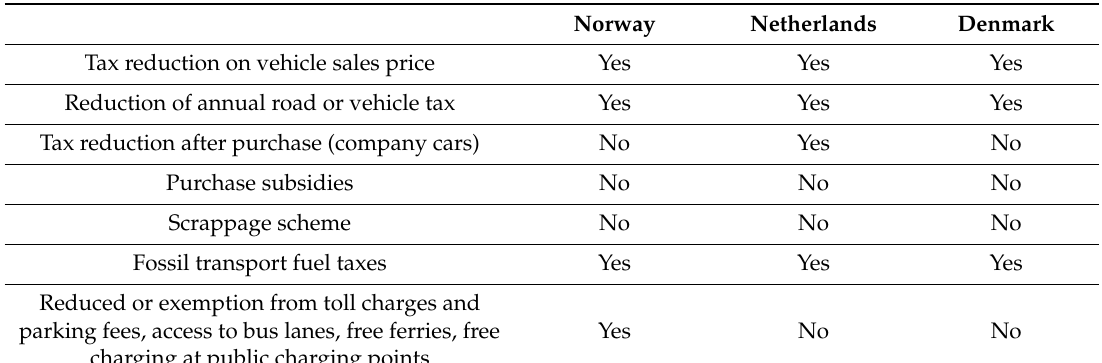
Table 3. Overview of full battery-electric vehicles (FBEV) demand-side policies in Norway, the Netherlands and Denmark 2010–2015 (source: adapted from [38]).